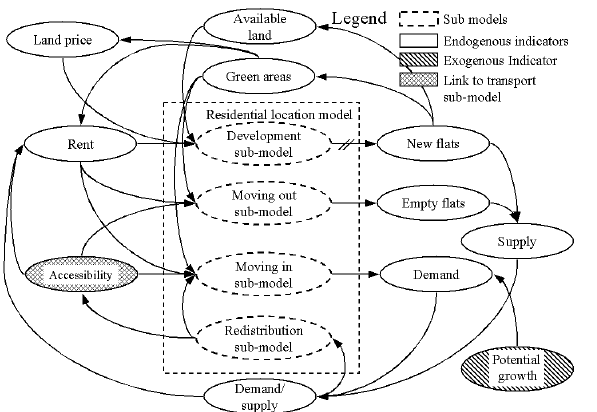
Figure 4: Sub-system diagram residential location